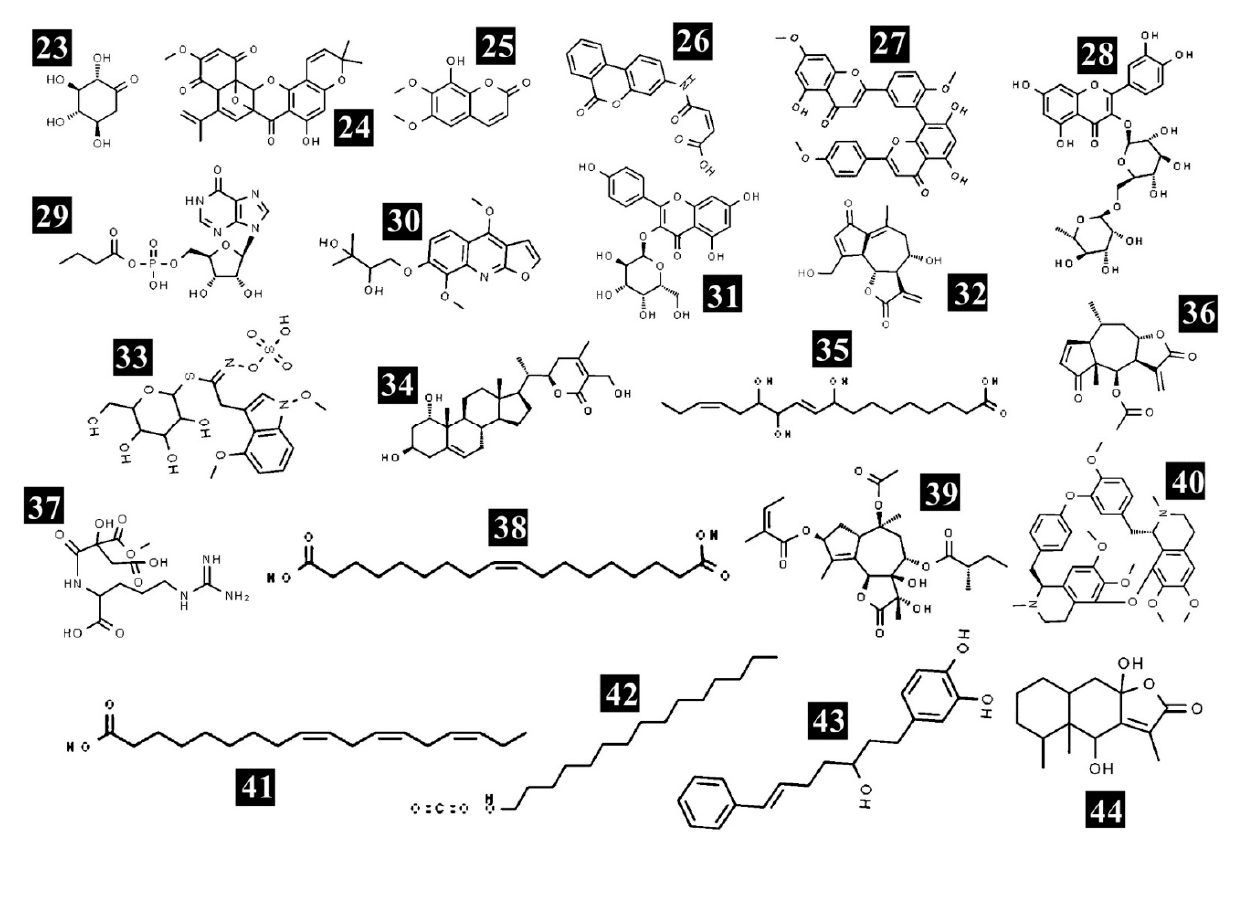
Figure 2. ( A ). Chemical structures of the identified compounds in E. sativa crude extract. (1) (+/-)-3- [(2-methyl-3-furyl)thio]-2-butanone; (2) methyl N -methylanthranilate; (3) 4-Amino-2-methyl-1- naphthol; (4) indoleacrylic acid; (5) pyrafoline D; (6) petasitenine; (7) nopaline; (8) Serinyl- Hydroxyproline; (9) afzelechin; (10) N -trans-Feruloyl-4- O -methyldopamine; (11) ( ± )-rollipyrrole; (12) N6-cis-p-Coumaroylserotonin; (13) 1-Methoxy-1H-indole-3-carboxaldehyde; (14) (10Z,14E,16E)- 10,14,16-Octadecatrien-12-ynoic acid; (15) 3,4 ′ ,5,6,8-Pentamethoxyflavone; (16) terminaline; (17) palmitic amide; (18) oleamide; (19) pheophorbide a; (20) pyropheophorbide a; (21) glucoraphanin; and (22) (S)-2-(Hydroxymethyl)glutarate. ( B ). Chemical structures of the identified compounds in E. sa- tiva crude extract. (23) 2-Deoxy-scyllo-inosose; (24) artomunoxanthentrione epoxide; (25) fraxidin; (26) N -(6-Oxo-6H-dibenzo[b,d]pyran-3-yl) maleamic acid; (27) sciadopitysin; (28) rutin; (29) 5 ′ -Bu- tyrylphosphoinosine; (30) evoxine; (31) kaempferol 3- O - β - D -galactoside; (32) lactucin; (33) 1,4-Di- methoxyglucobrassicin; (34) pubesenolide; (35) corchorifatty acid F; (36) linifolin A; (37) N2-(2-Car- boxymethyl-2-hydroxysuccinoyl)arginine; (38) 9Z-Octadecenedioic acid; (39) trilobolide; (40) thali- dasine; (41) α -linolenic acid; (42) 16-Hydroxy hexadecanoic acid; (43) 4-(3-Hydroxy-7-phenyl-6-hep- tenyl)-1,2-benzenediol; and (44) (6beta,8betaOH)-6,8-Dihydroxy-7(11)-eremophilen-12,8-olide.